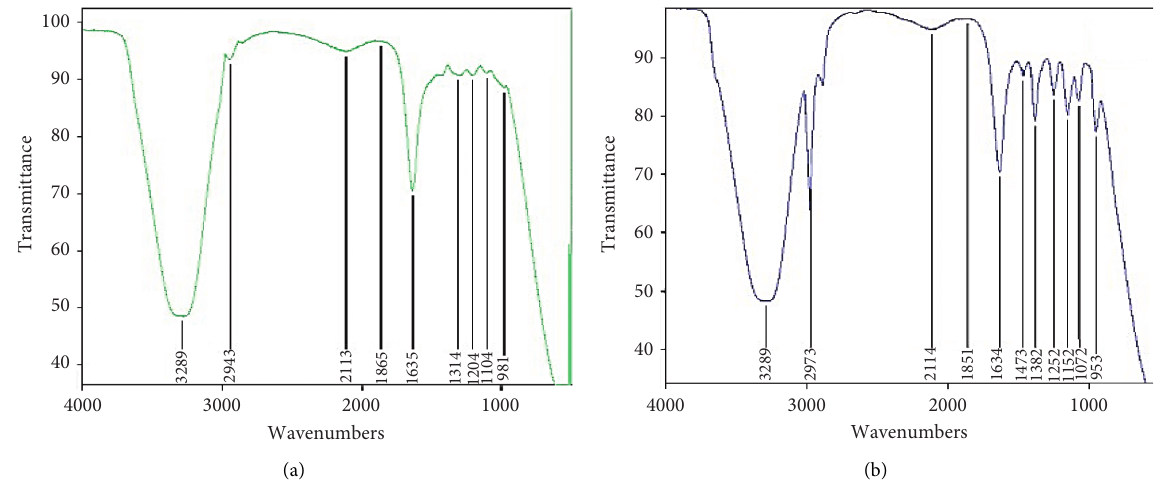
Figure 4: FTIR spectra of (a) aqueous and (b) methanolic G. perpensa -mediated AgNPs. Table 1: Antibacterial activity of AgNPs from the aqueous and methanolic leaf extracts of G. perpensa .